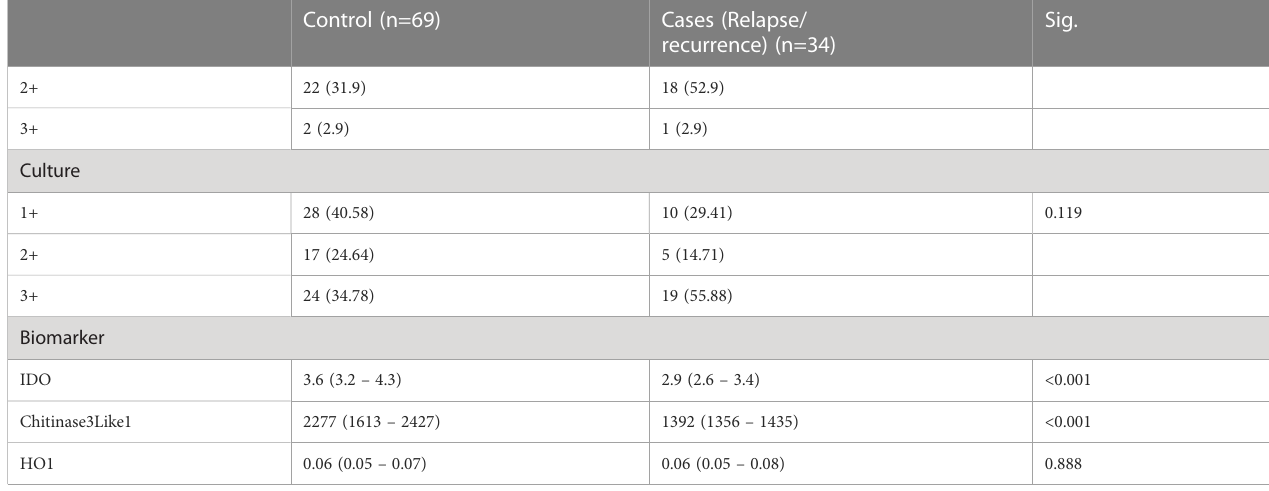
TABLE 1C Patients characteristics for individuals with TB treatment failure.